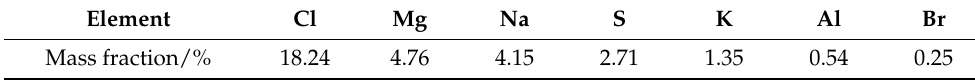
Table 1. Chemical composition of waste